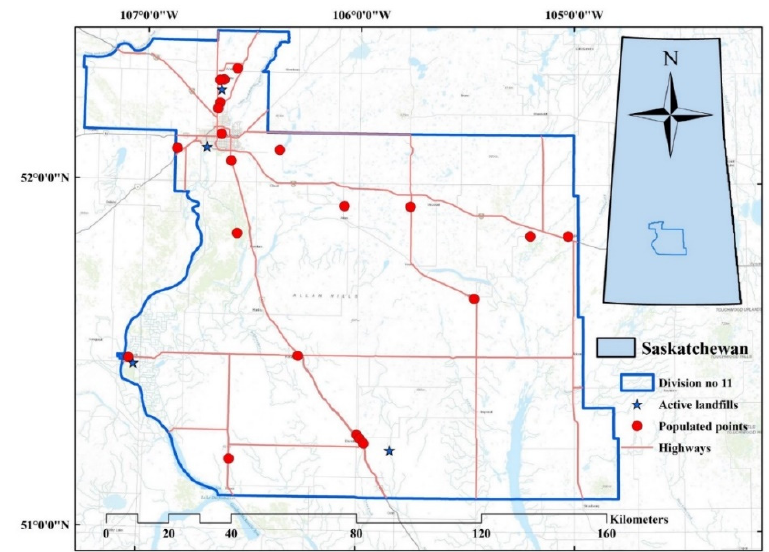
Figure 2. Location of Division 11 in the province of Saskatchewan, Canada. Table 1. Details of the study area. Characteristics of Division 11 Total population